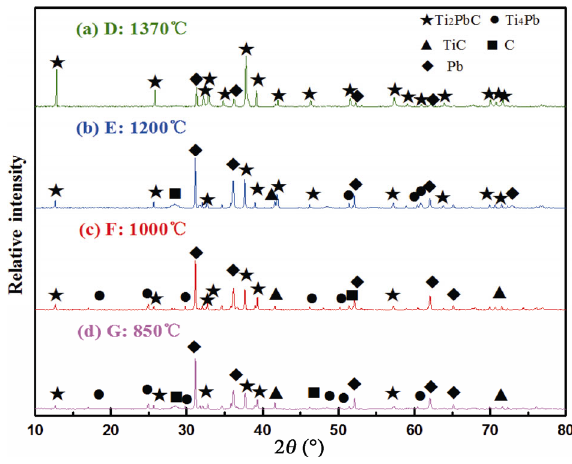
Fig. 2 XRD patterns of samples D–G synthesized from Ti/Pb/TiC at a heating rate of 2